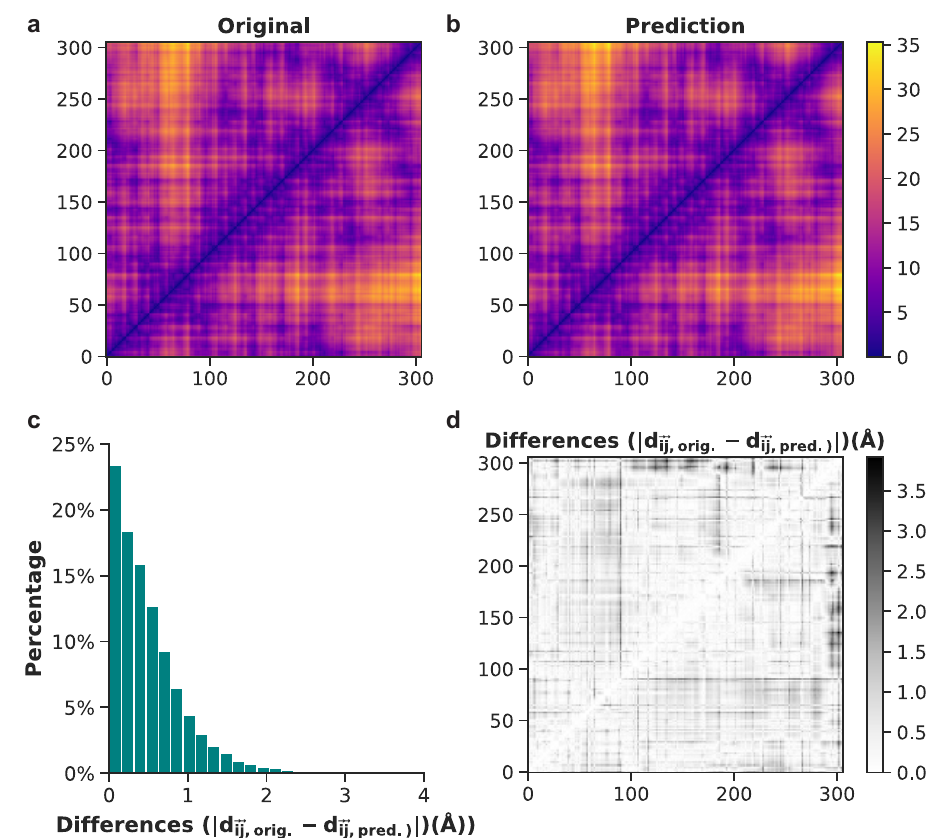
Figure 8. Comparison between original and predicted pairwise interatomic distances for frame 1133 (from the test set). ( a ) Actual distances are shown for all heavy atoms. ( b ) Heavy-atom predictions of all pairwise interatomic distance. ( c ) Histogram of differences between original and predicted Euclidean distances. ( d ) Binary plot displaying the absolute difference values between each actual and predicted distance for frame